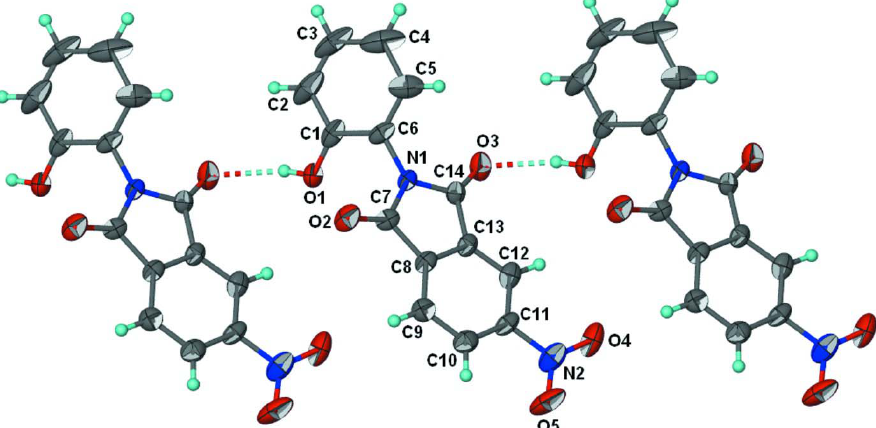
Figure 1 Thermal ellipsoid plot (Barbour, 2001) of O–H···O hydrogen-bonded structure of C Dashed lines denote the intermolecular hydrogen bonds. Hydrogen atoms are drawn as spheres of arbitrary radius. Only the major component of disorder is